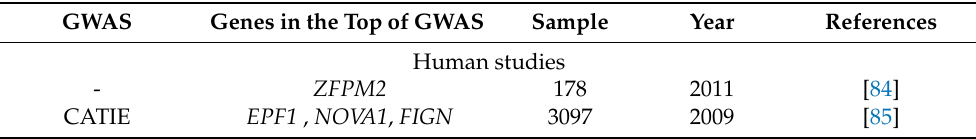
Table 5. GWAS of antipsychotic-induced parkinsonism.